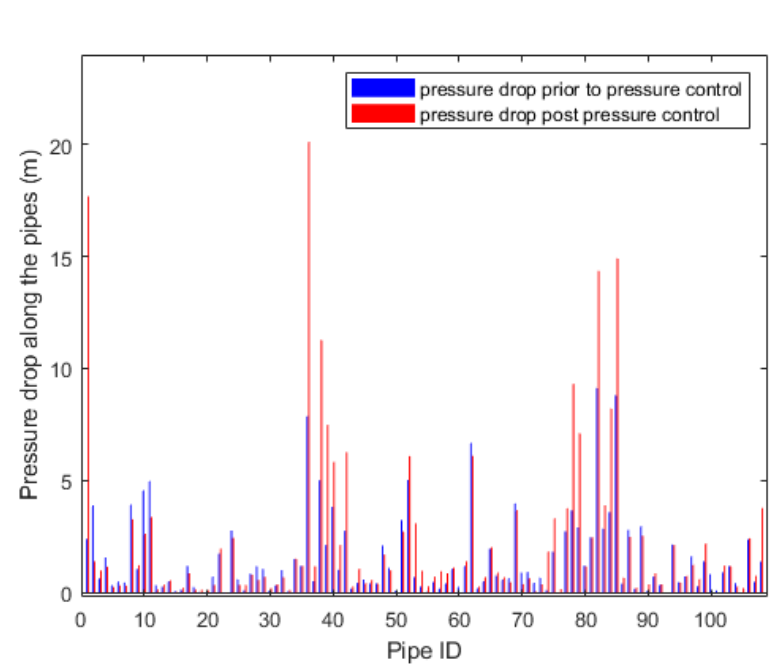
Figure 7. Nodal pressure heads for case study